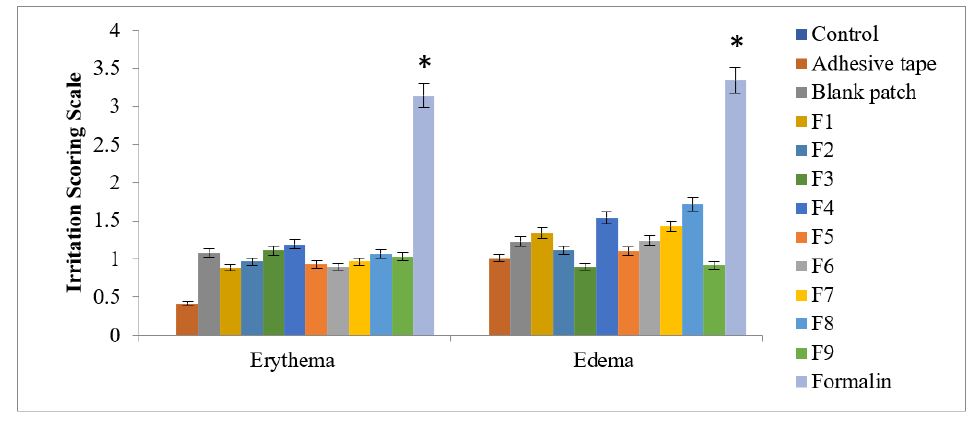
Figure 2. Skin irritation study: edema and erythema. Data are expressed as mean ± SD; n = 3. The results were significant compared to formalin (one-way ANOVA followed by post hoc Tukey test; p < 0.05).